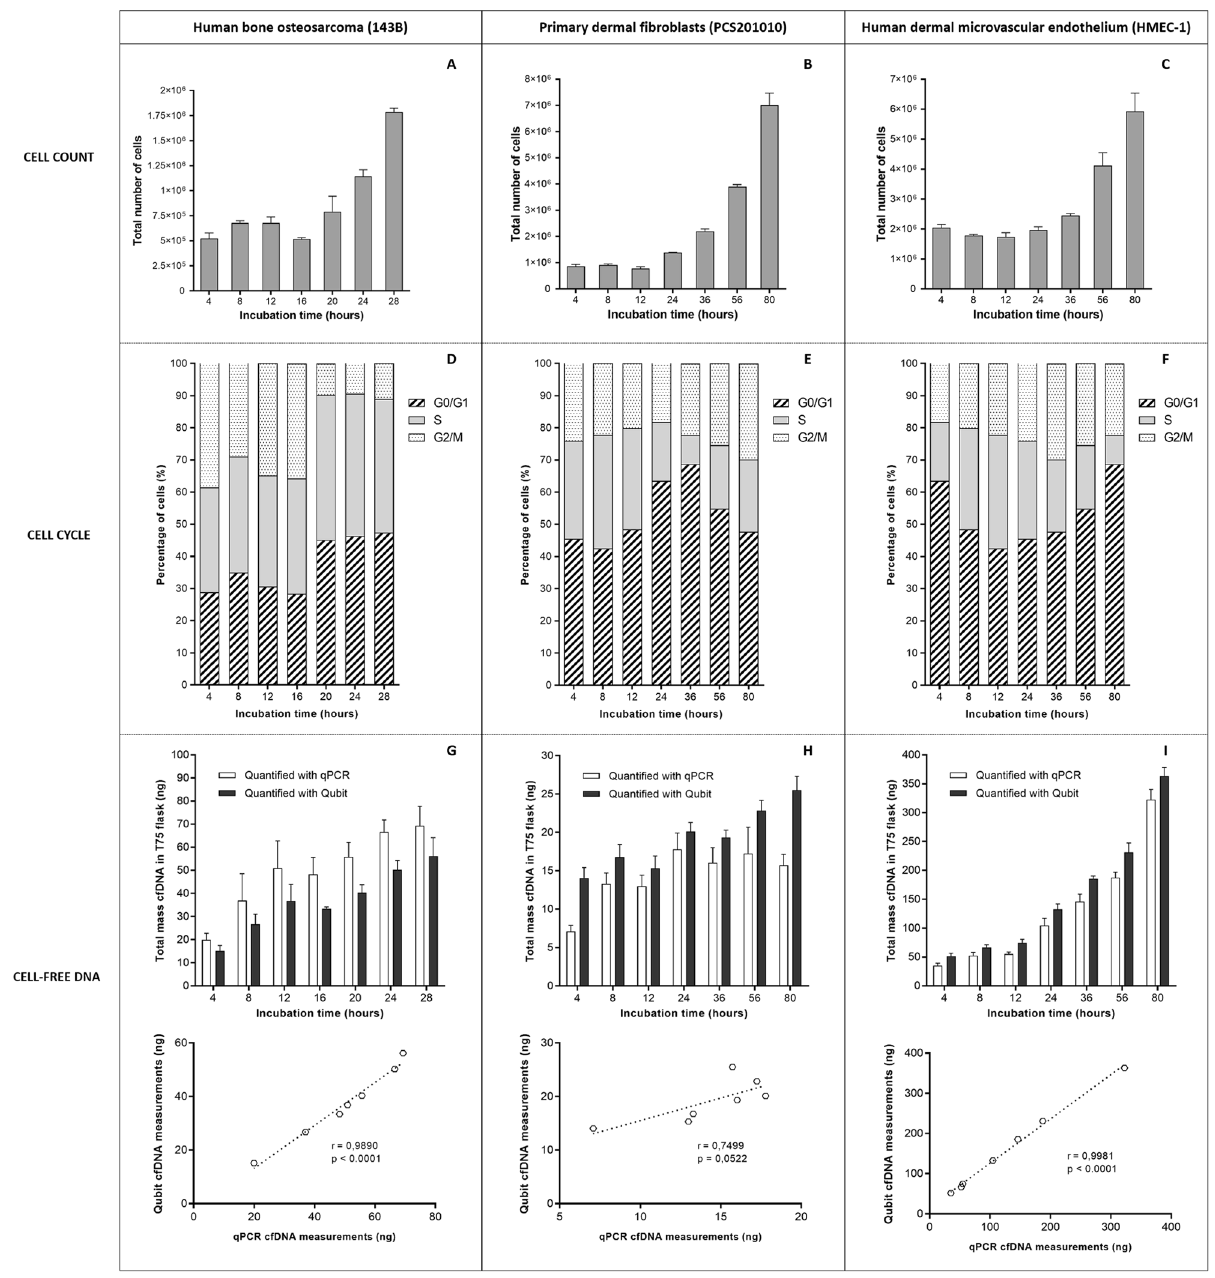
Figure 1. Longitudinal measurements of cell number, cell cycle and total cell-free DNA in three cell lines. A cell count and viability assay was used to determine the total number of cells present in a T-75 culture flask after different incubation times for ( A ) human bone osteosarcoma (143B), ( B ) primary dermal fibroblasts (PCS201010), and ( C ) human dermal microvascular endothelial cells (HMEC-1). Changes in the phase of cell cycle over increasing incubation times were measured in ( D ) 143B, ( E ) PCS201010, and ( F ) HMEC-1 cells using a cell cycle assay kit. The relative number of cells in the G0/G1, S, or G2/M phases, respectively, at each incubation time-point is expressed as a percentage of the whole. CfDNA was collected from ( G ) 143B, ( H ) PCS201010, and ( I ) HMEC-1 cell culture supernatant after different incubation times and quantified with a β-globin based PCR assay (white bars) and Qubit dsDNA HS Assay (black bars), respectively. The values are expressed as the total amount of cfDNA (ng) present in a T-75 culture flask. The statistical correlation between qPCR and Qubit measurements for each cell line is shown below the respective cfDNA quantification graphs. Each time-point bar represents the mean values of two biological replicates (measurements made from two separate cell culture flasks). Error bars indicate standard deviation. R-values close to 1 indicate perfect correlation, while R-values close to zero indicate no correlation. P-values < 0.05 indicate statistical